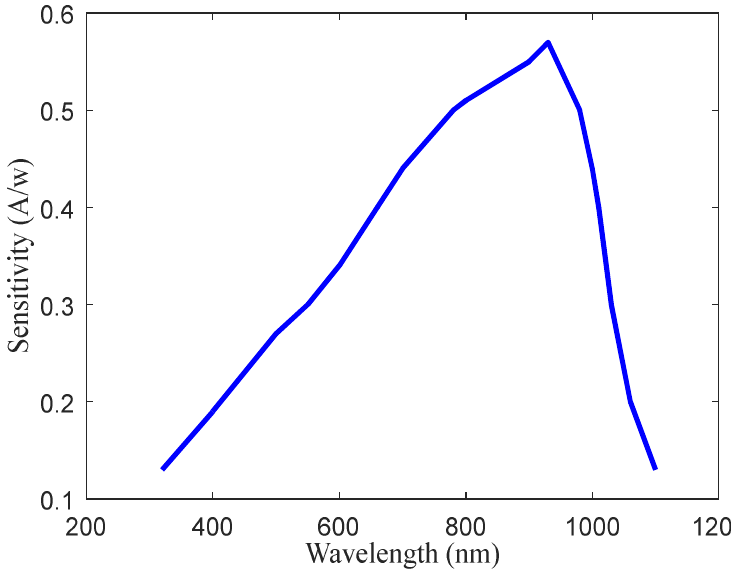
Figure 10. The sensitivity of the photocell.